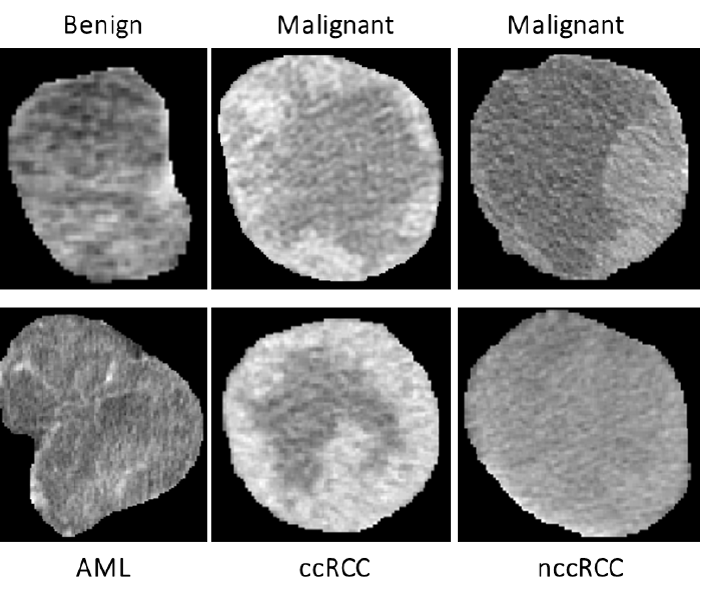
Figure 5. An illustrative example showing differences in texture between various renal tumor types. First-order textural features: These textural features include any quantity that can be derived from the gray-level histogram of the tumor volume. In particular, mean, variance, standard deviation, entropy, skewness, kurtosis, cumulative distribution functions, and the grey-level percentiles [49] were